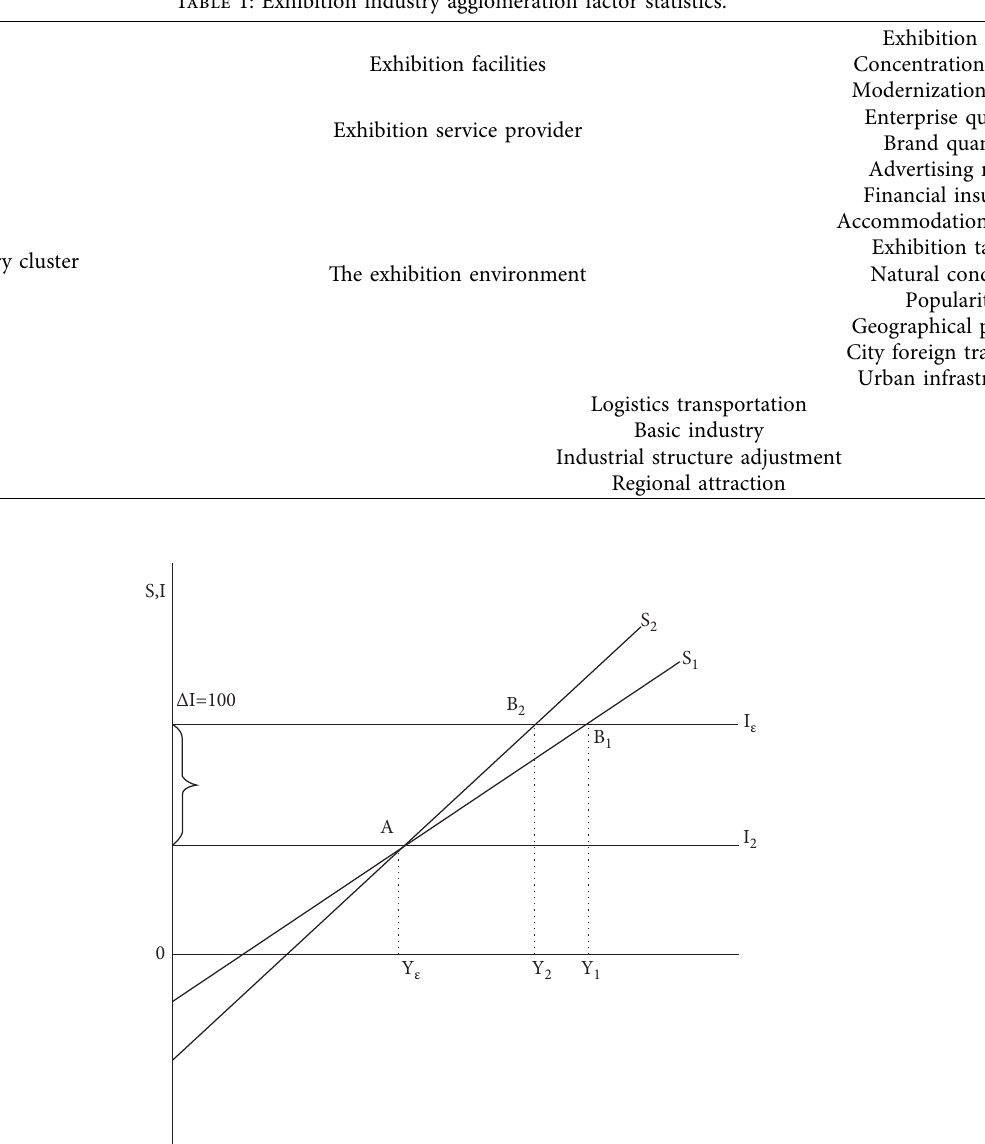
Table 1: Exhibition industry agglomeration factor